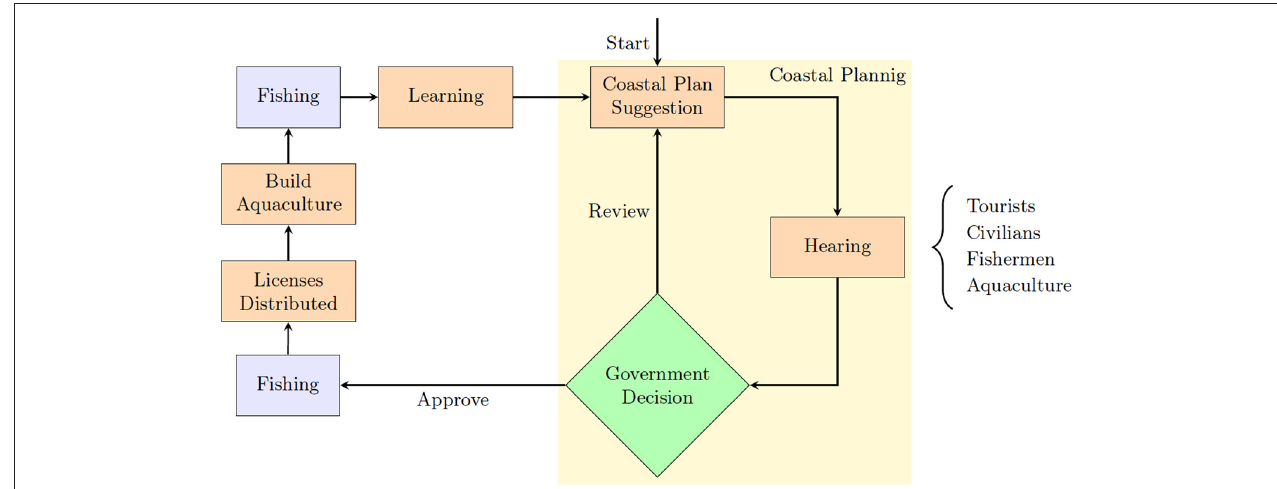
FIGURE 4 | Process chart of the